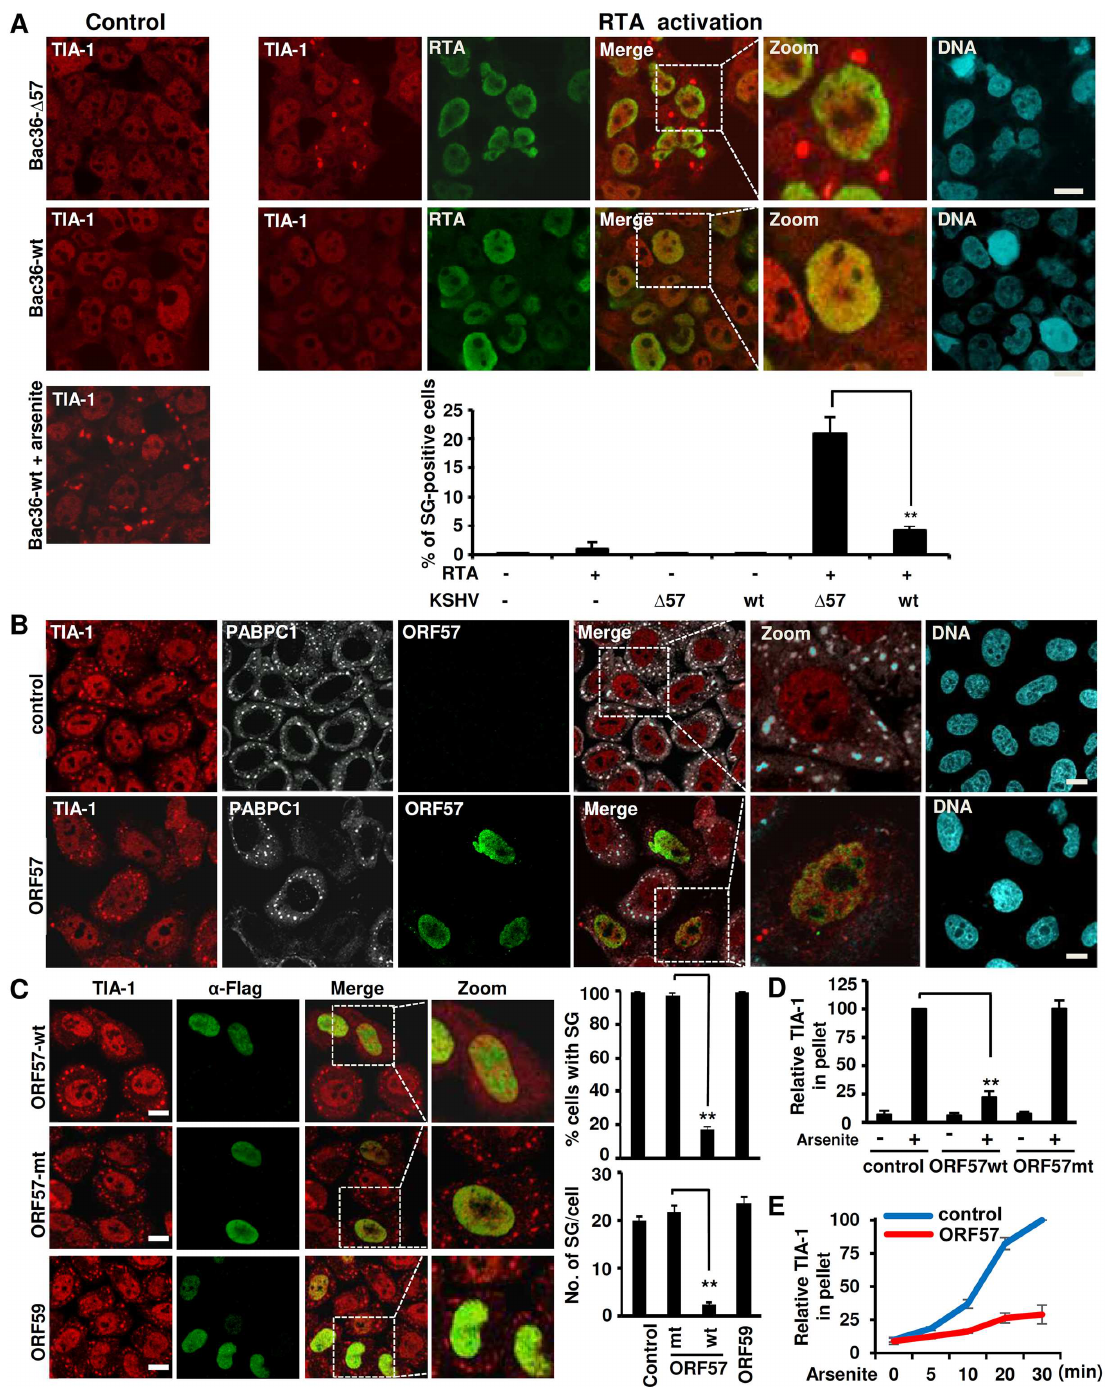
Fig 2. Viral ORF57 expression is required to suppress the formation of SG during KSHV lytic infection and under arsenite stress. (A) ORF57 expression is requiredto inhibit the formation of SG duringKSHV lytic infectionreactivatedby RTA. Bac36 cells (wt or Δ 57) were transfected either with a vector control (control) or with an RTA expressionvector (RTA activation) to induce lytic KSHV infection. To observe SG, the cells were stainedfor TIA-1 (red) along with RTA (green)by each specific antibody.A positive control for SG was also set by arsenite treatment on Bac36 wt cells transfected with an empty vector. The nuclei were counterstained with Hoechst stain. Scale bar = 10 μ m. Bar graph below the images shows the cells forming SG before and after virus lytic reactivation through RTA expression. HEK293cells transfected with an empty or RTA expressing vector served as a negative control. Total of 100 cells in each group were countedin each experiment. The error bars represent